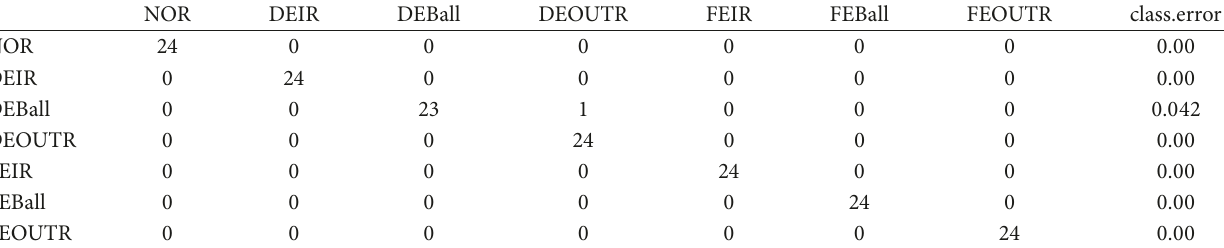
Table 4: Random Forest classification results of EEMD matrix.